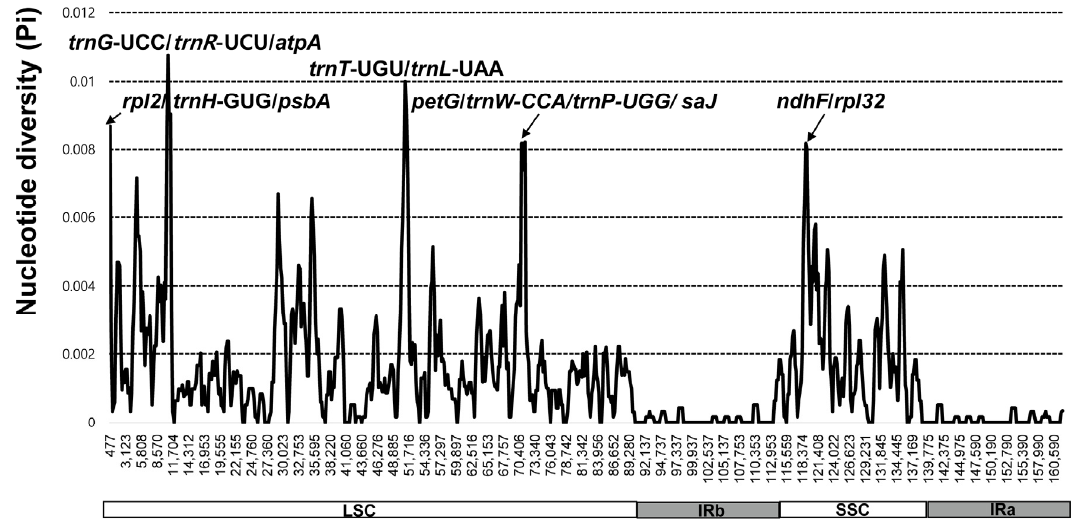
Figure 4. Sliding window analysis of the 15 whole-chloroplast genomes of Cotoneaster species. Table 2. Log-Likelihood values of site-specific models, with detected sites having dN/dS values > 1.